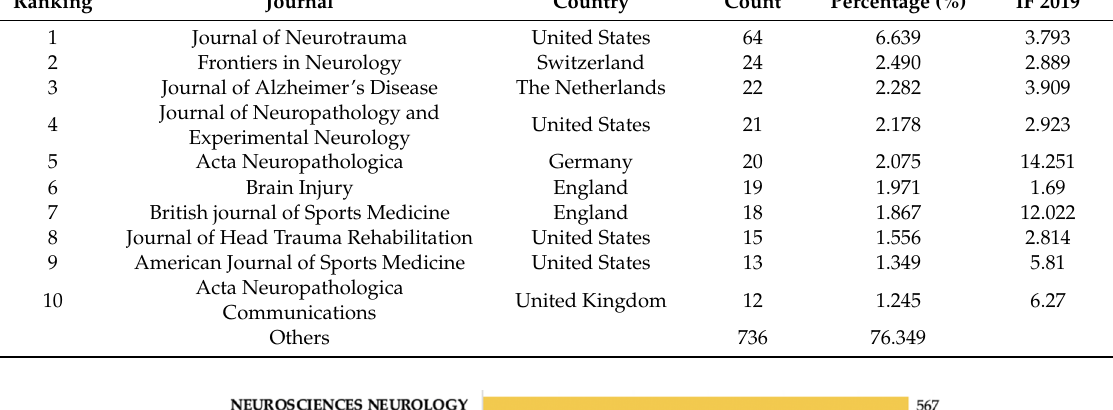
Table 2. Ranking of top 10 active journals that published articles on CTE research from 1999 to 2019.